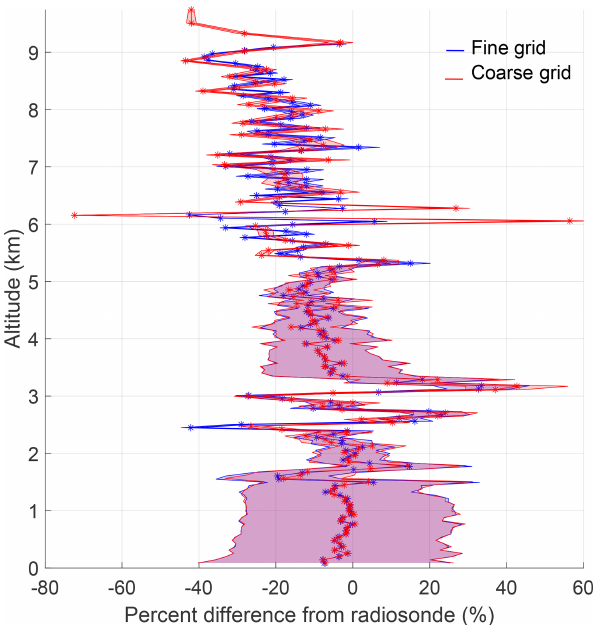
Figure 12. The percent difference from the radiosonde for both the fine- and coarse-grid retrievals. Both show similar differences with the radiosonde and the last valid height is